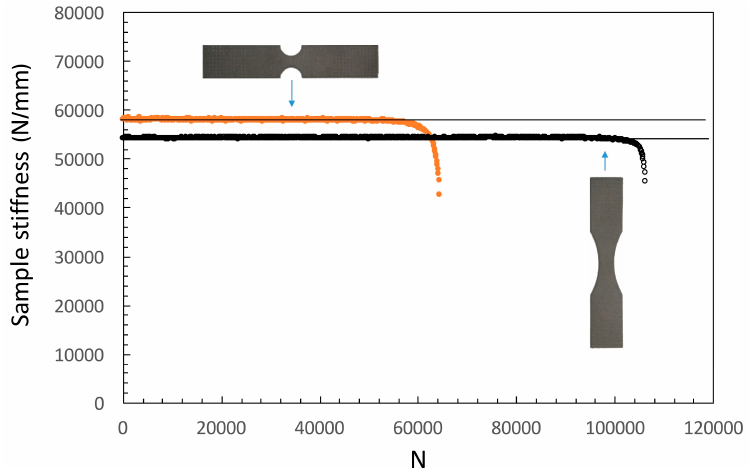
Figure 8. Sample stiffness as a function of cycle number from a smooth and a circular notched sample, both loaded with a nominal stress ( σ n ) value of 360 MPa.